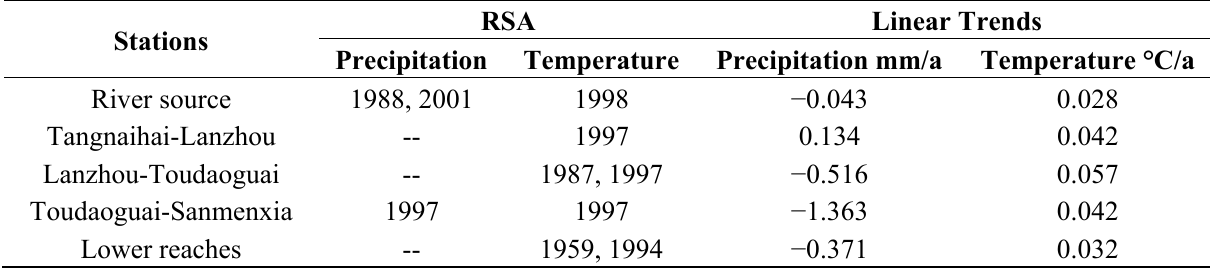
Table 4. Variation in the annual precipitation and temperature in the Yellow River basin over the past six